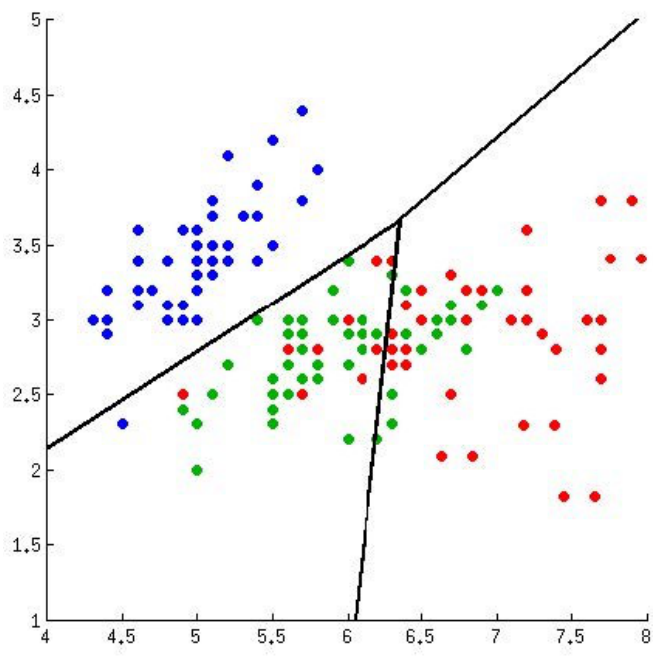
Fig. 3 Wavelet variance of the smooth subgraph of farmland landscape